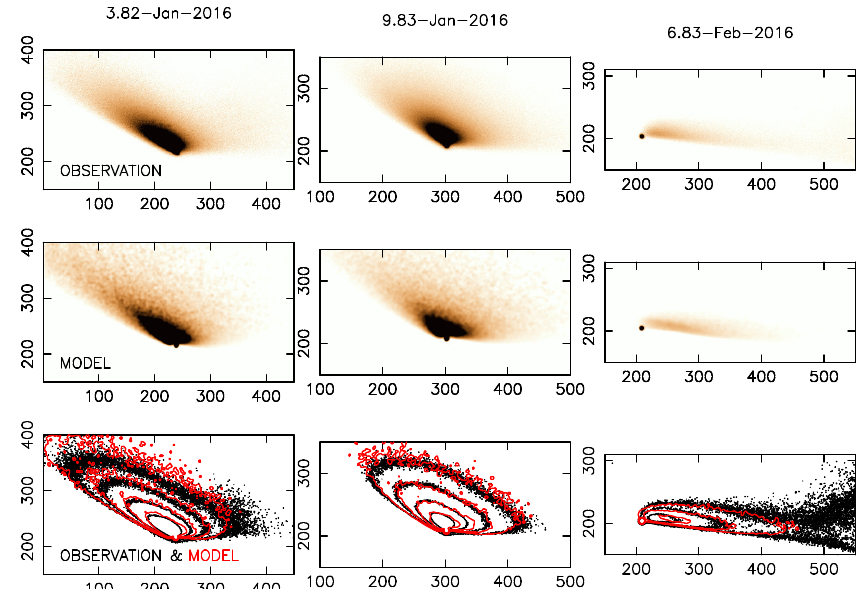
Figure 6. Upper panels: observations of comet 249P/LINEAR with the instrument OSIRIS (Optical System for Imaging and Low-Intermediate-Resolution Integrated Spectroscopy) at the 10.4 m Gran Telescopio Canarias (GTC) at the indicated epochs. Middle panels: best-fit synthetic images obtained through minimization in the four-dimensional dust parameter space with the Monte Carlo dust tail code. Lower panels: isophote fields (black contours, observation; red contours, model). All the images are oriented in the north-up east-to-the-left conventional orientation. The x- and y-axis are given in pixels. The physical dimensions of the images are, in km × km, and from left to right,